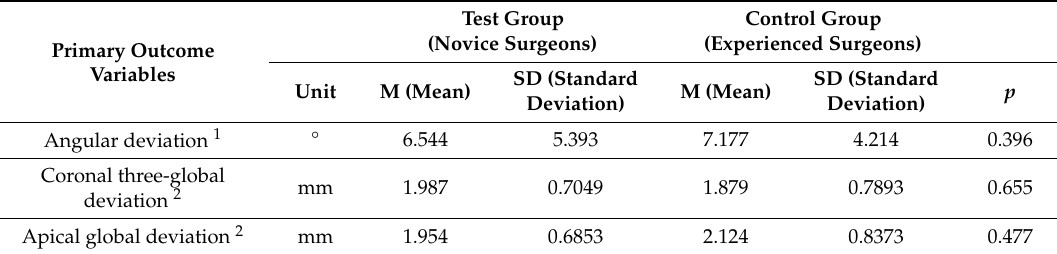
Table 1. Descriptive and comparative statistics of the primary outcome variables between the two study